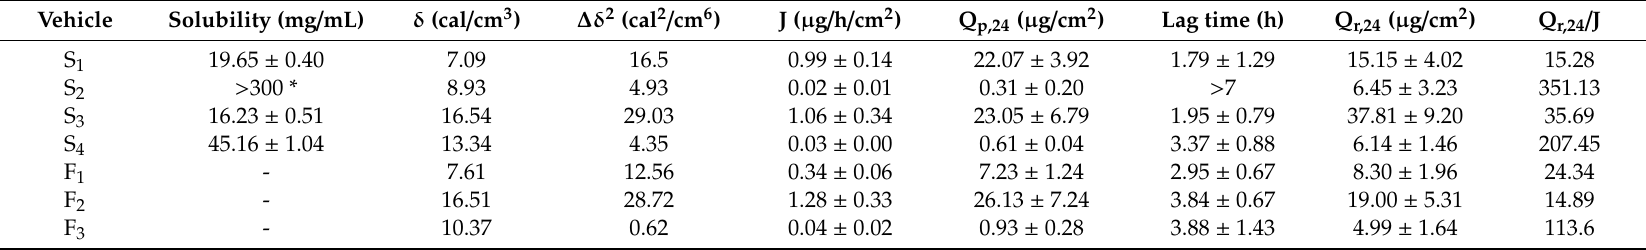
Table 1. Cannabidiol (CBD) solubility in tested solutions (S 1 –S 4 ); solubility parameters of placebo vehicles ( δ ) and ∆ δ 2 values; in vitro CBD skin permeation parameters (steady-state flux (J), cumulative permeated amount at 24 h (Q p,24 ), retained amount at 24 h (Q r,24 ) and Q r,24 / J ratio of tested solutions (S 1 –S 4 ), and vehicle formulations (F 1 –F 3 ). Means ± SD ( n ≥